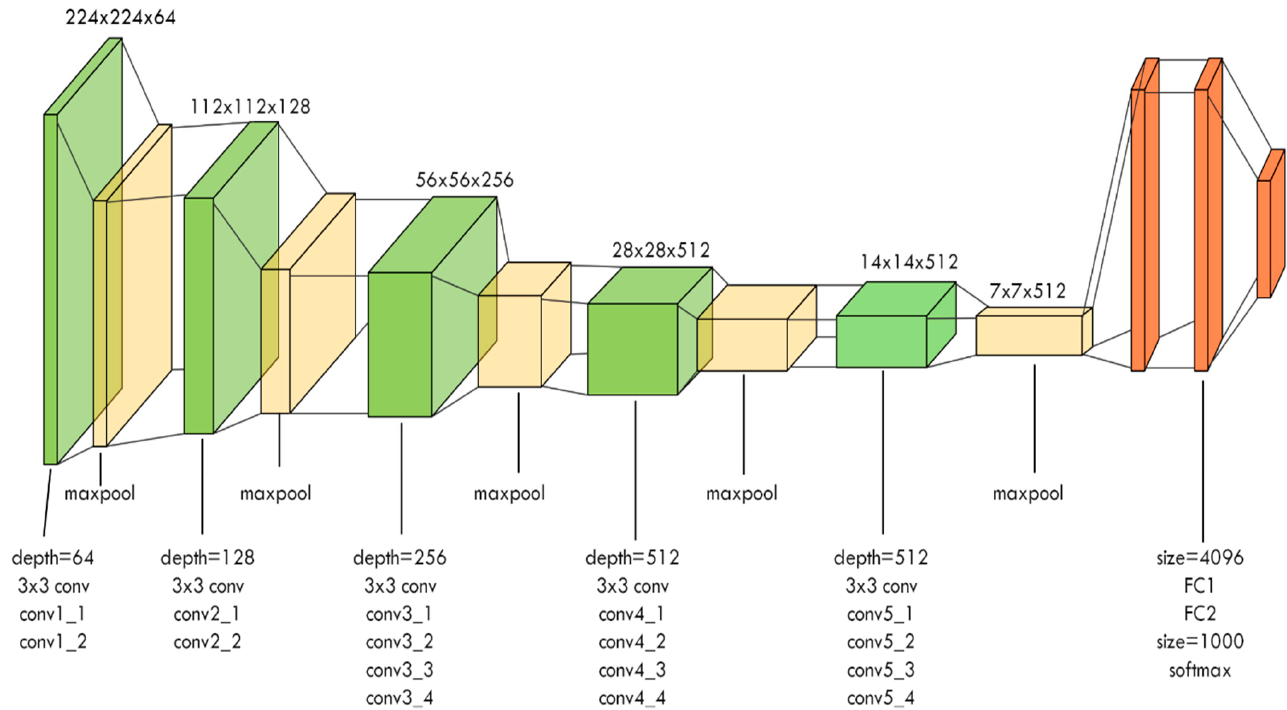
Figure 3. VGG-19 network architecture: conv stands for convolution, FC stands for fully connected [30].